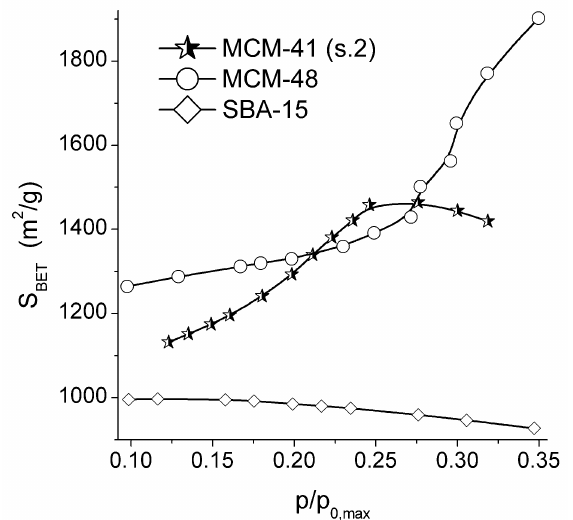
value of the pressure range (0.05 – 0